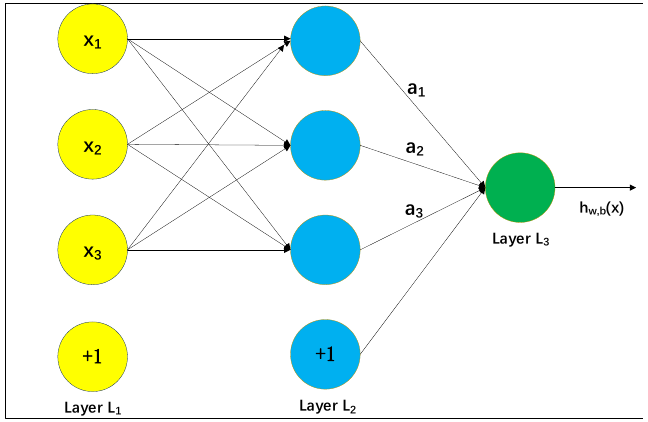
Figure 1. Neural network